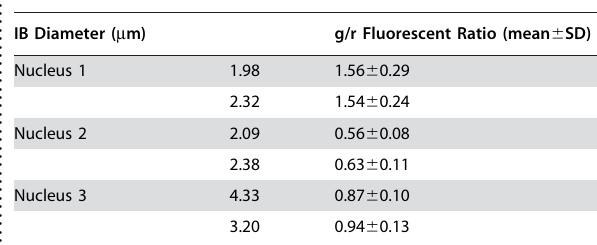
Table 1. Green/Red Fluorescence ratios in IBs of DsRed1-E5-